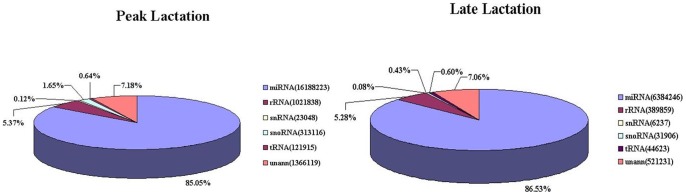
Distribution of small RNAs among different categories in peak and late lactation.The clean reads were annotated and classified as miRNA, rRNA, tRNA, snRNA and snoRNA in GenBank and Rfam databases, and partial reads were not annotated.